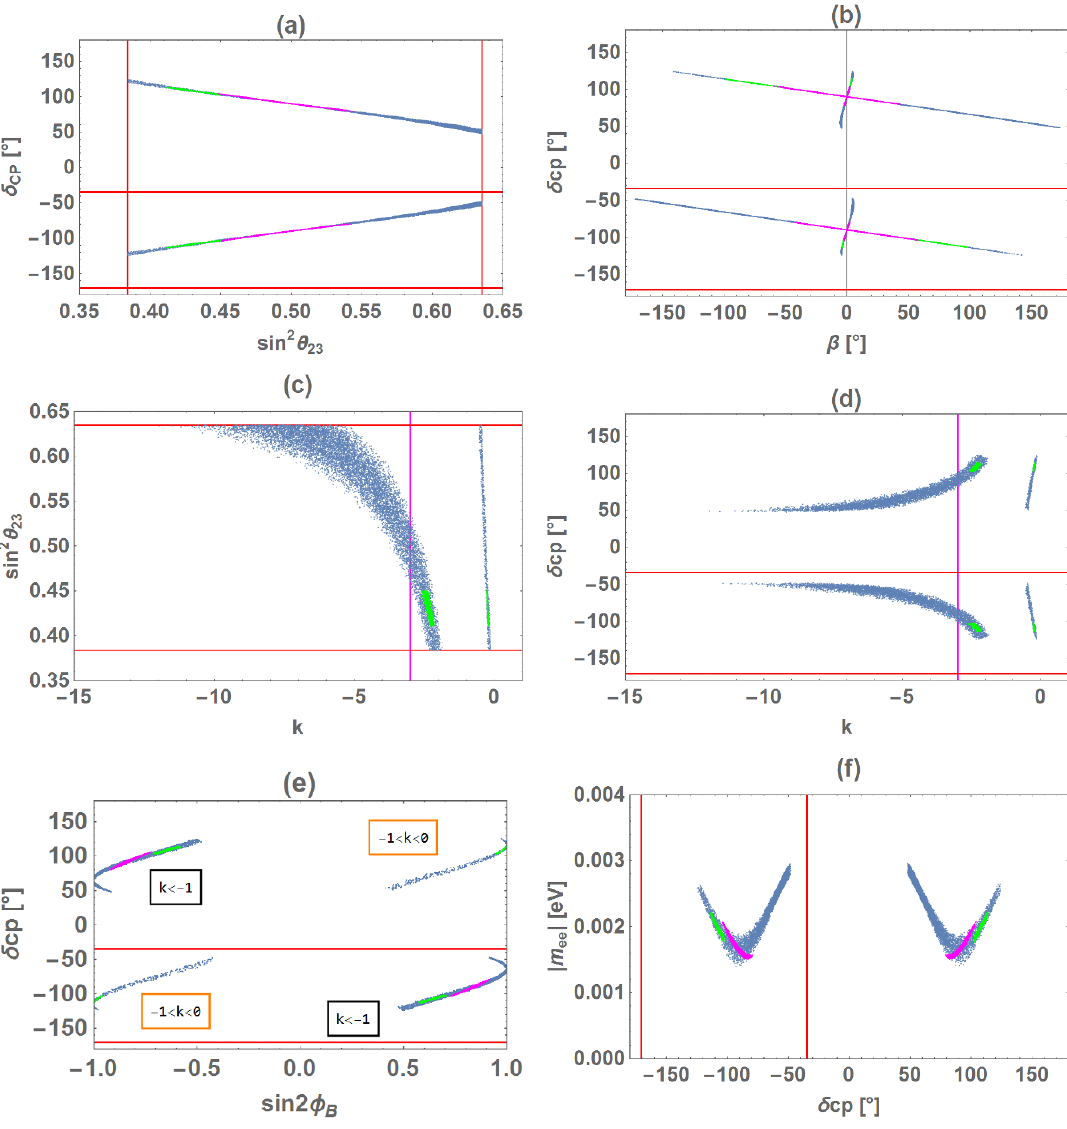
Figure 1 . Blue (green) dots denote predictions for case I within 3 (cid:27) (1 (cid:27) ) range. The red lines for sin 2 (cid:18) 23 and (cid:14) CP denote the experimental bounds of 3 (cid:27) (global analyses) and 2 (cid:27) (T2K) ranges, respectively: (a) (cid:14) CP versus sin 2 (cid:18) 23 , (b) (cid:14) CP versus (cid:12) , (c) sin 2 (cid:18) 23 versus k , (d) (cid:14) CP versus k , (e) (cid:14) CP versus sin 2 (cid:30) B , and (f) j m ee j versus (cid:14) CP . The magenta dots in (a), (b), (e) and (f) denote the predictions of the Littlest seesaw model. The vertical magenta lines of k = (cid:0) 3 in (c) and (d) also denote its